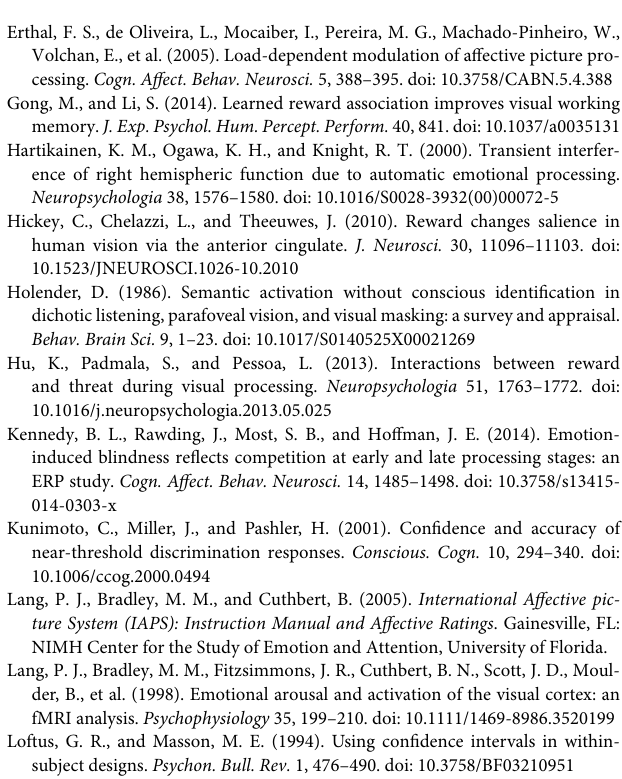
interference. (B) During competition between task-irrelevant high-arousing negative stimuli and task-relevant stimuli with high motivational significance, motivationally significant stimuli more effectively compete with negative